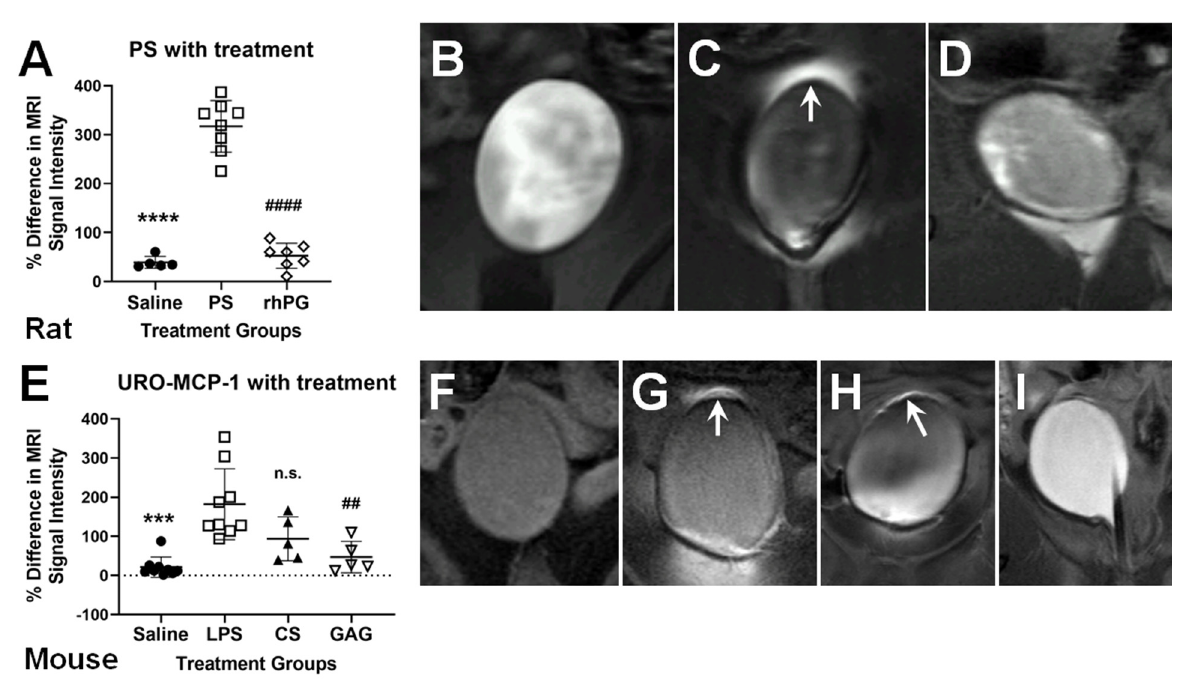
Figure 2. Using CE-MRI to detect therapeutic efficacy against BWH. Rat protamine sulfate (PS)-induced BWH model with treatment ( A – D ). ( A ) Quantitative assessment of BWH in a rat protamine sulfate PS-induced cystitis model treated with either saline (normal control; closed circles)), PS (open squares) or a recombinant human proteoglycan (rhPG; open diamonds); 3 days post PS. There was a significant difference between the rhPG and PS groups (#### p < 0.0001). **** p < 0.0001 (PS-treated significantly higher than saline control). ( B – D ) Representative CE-MR images of saline- ( B ), PS- ( C ), or rhPG-treated ( D ) rat bladders. White arrow in panel “C” depicts high MRI signal intensity (SI) due to BWH. Transgenic mouse IC/BPS model with treatment ( E – I ). ( E ) Quantitative assessment of BWH in a transgenic URO-MCP-1 mouse lipopolysaccharide (LPS)-induced IC model treated with either saline (normal control; closed circles), LPS (open squares), chondroitin sulfate (CS; closed upward triangles)), or a super-glycosaminoglycan (GAG; open downward triangles); 5 days post LPS. There was a significant difference between the GAG and LPS groups (## p < 0.01). *** p < 0.001 (PS-treated significantly higher than saline control). The CS group was not significantly different than the LPS group. ( F – I ) Representative CE-MR images of saline- ( F ), LPS- ( G ), CS- ( H ) or GAG-treated ( I ) mouse bladders. Note BWH (white arrows) in frames ( G , H ). Figures were modified from those published in Refs. [44,45].